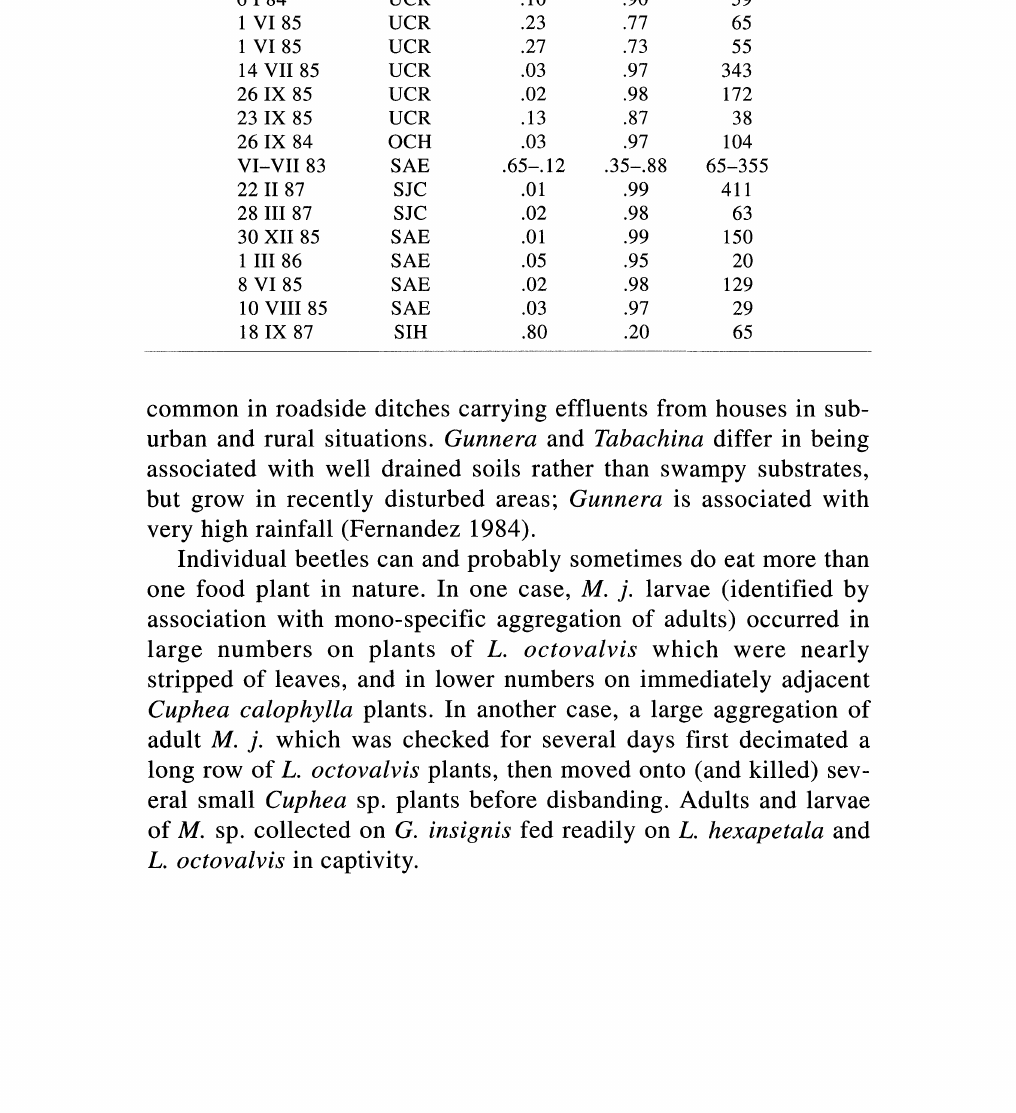
Psyche [Vol. 100 Table 2. Proportions of M. jamaicensis and M. sp. in mixed aggregations in the field on L. octovalvis plants (all purple individuals were classified as M. sp.; some may have been hybrids). An estimated minimum of 50-100 other aggregations of only M. j., and 10-30 mixed aggregations were also seen on this plant. (OCH Ochomogo, just W. of Cartago; SAE San Antonio de Escazu; SIH San Isidro de Heredia; UCR Universidad de Costa